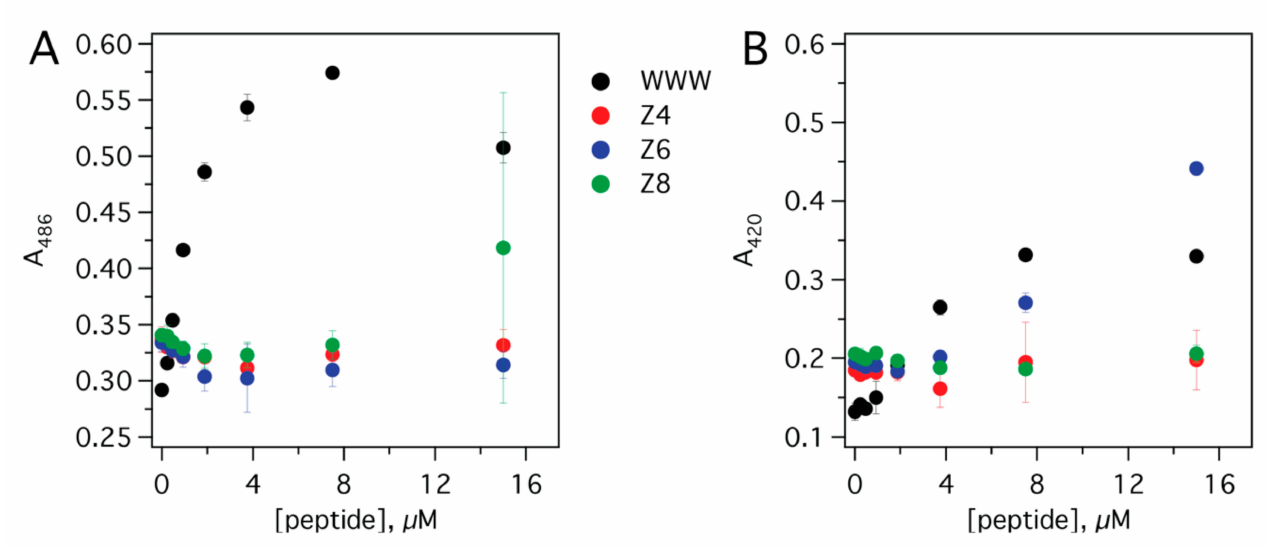
Figure 2. Bacterial membrane permeabilization. The permeabilization of the bacterial ( A ) outer membrane and ( B ) inner membrane is shown after 30 min of exposure to peptides. The chromogenic substrates used are ( A ) nitrocefin and ( B ) ONPG. Data shown are the averages of 3 trials with standard